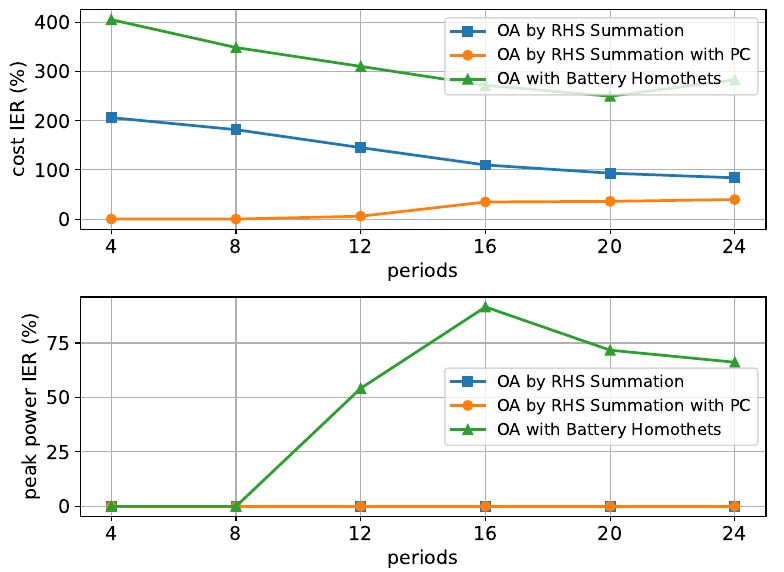
Figure 7. ( Top ): cost IER dependence on the number of time periods for 20 households; ( bottom ): peak IER dependence on the number of periods for 20